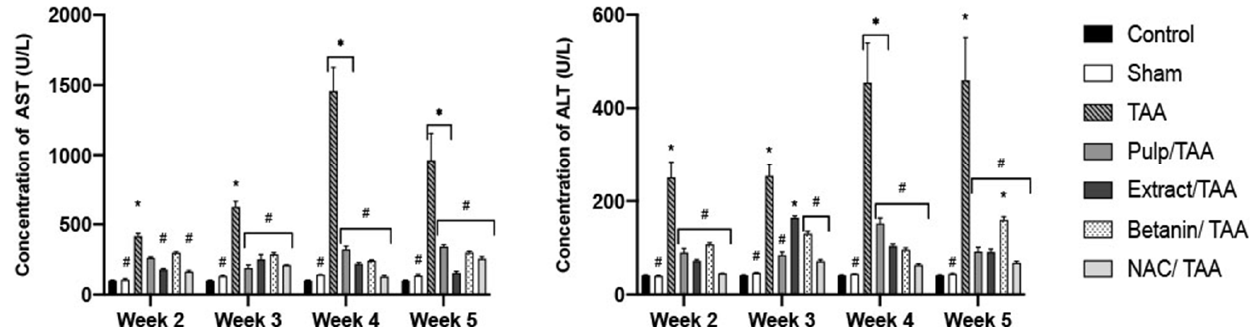
Figure 4. Aspartate aminotransferase (AST) and Alanine aminotransferase (ALT) concentrations for different treatments at different evaluation times. Two-way ANOVA with Tukey’s post hoc test. * p < 0.05 compared to control group, # p < 0.05 compared to thioacteamide group.